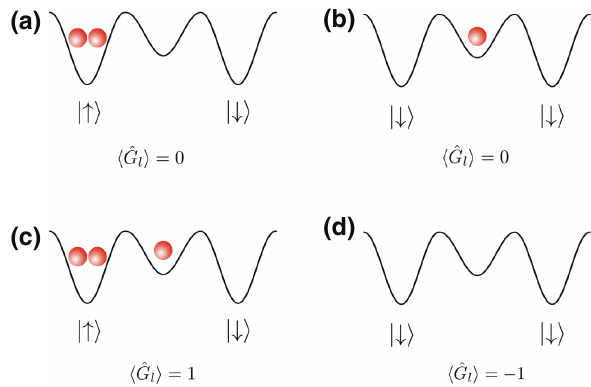
FIG. 2. Configurations with different values of the gauge charge: (a),(b) G = 0; (c) G = 1; (d) G = − 1.